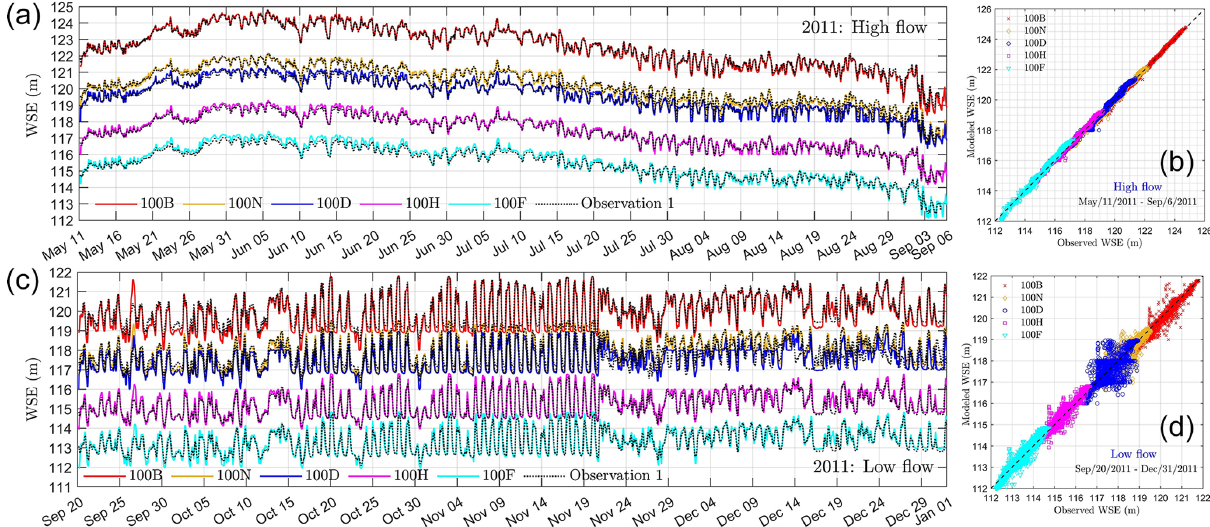
Figure 6. The comparison of water surface elevation from model and observations during high flow and low flow in 2011. (a–b) Hourly recorded time series of WSE and the 1 : 1 plot during high flow. (c–d) Hourly recorded time series of WSE and the 1 : 1 plot during low